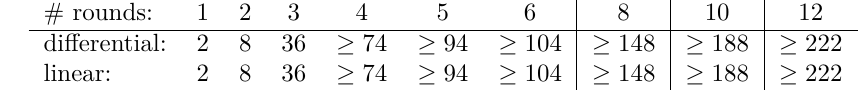
Table 3: The weight of the best differential and linear trails (or lower bounds) as a function of the number of